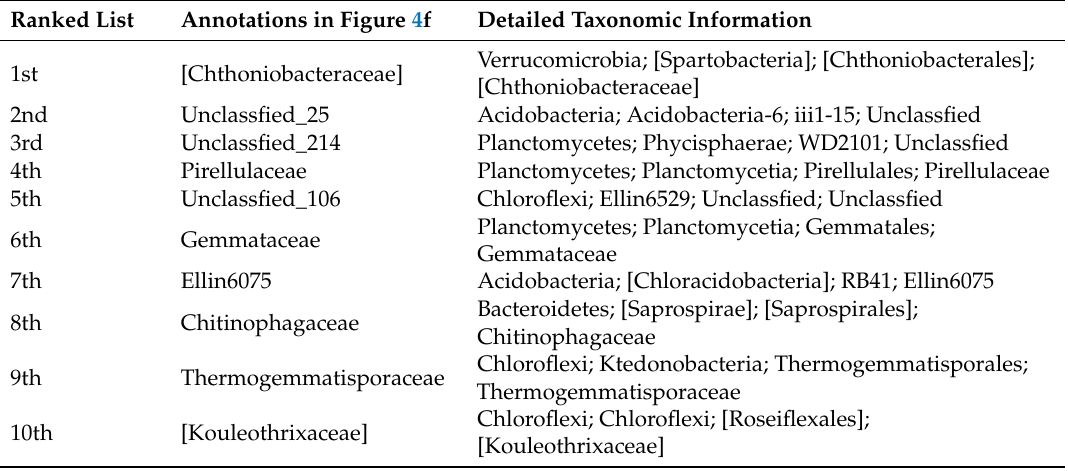
Table A3. The detailed taxonomic information of the top 20 bacteria of soil samples on family